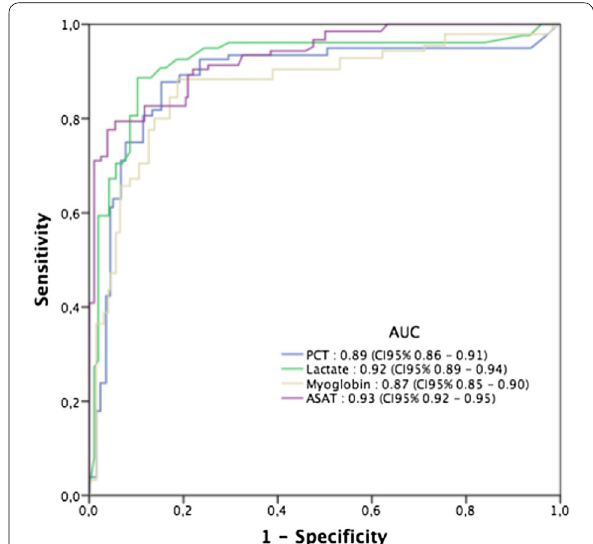
Fig. 2 Comparison of the ROC curves showing the sensitivity and specificity of each marker (PCT, ASAT, lactate and myoglobin) for predicting the diagnosis of bowel ischemia